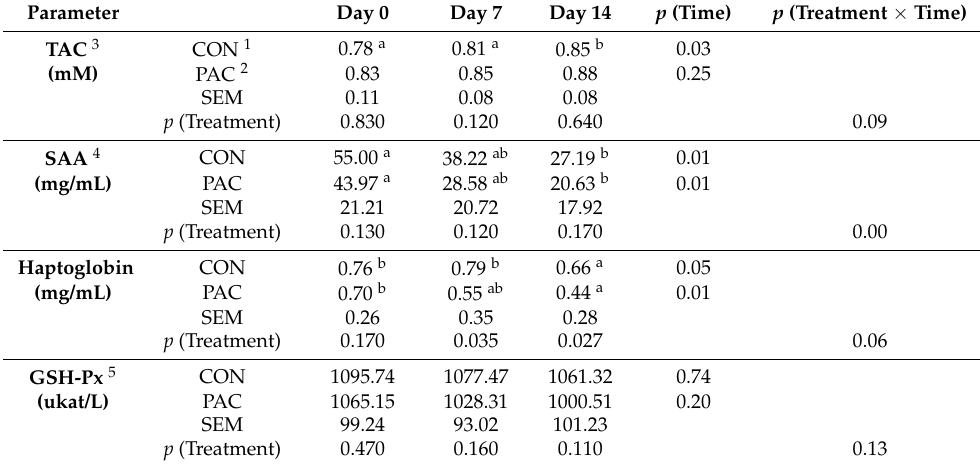
Table 4. Inflammation and antioxidant capacity markers in cows receiving plant bioactive compounds.